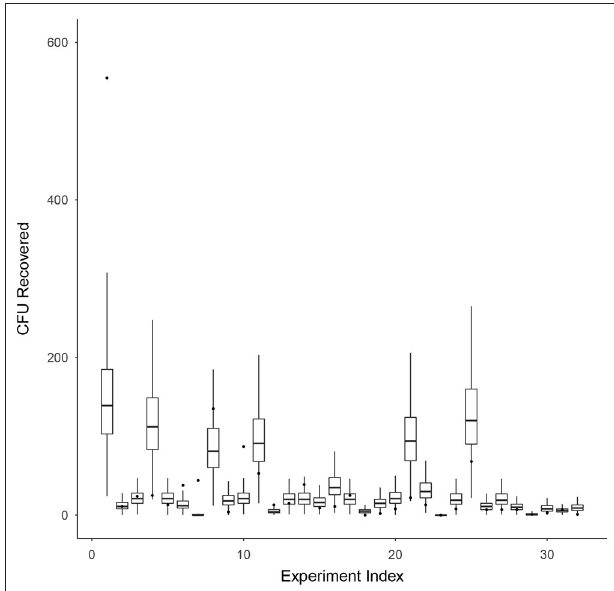
FIGURE 4 | Model validation for survival ratio experiments using Equation (7). This figure compares the model’s prediction of the number of CFU recovered (box-whisker plots) against the actual observed number of CFU recovered (black dots) on the vertical axis, for each experiment indexed by the integers 1–32 (horizontal axis). Box and whiskers show 50 and 95% credibility intervals, respectively, for the model’s prediction of the number of CFU recovered from each experiment. The mean model prediction is shown with a horizontal line on each box-whisker